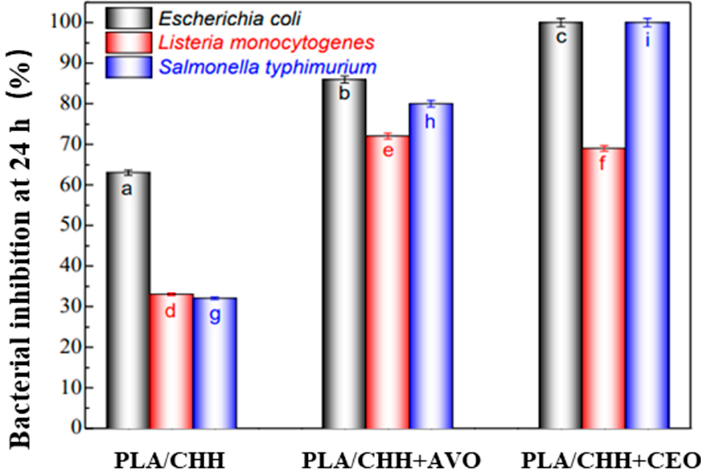
Figure 7. Variation of bacteria percentage inhibition determined by the CHH and oil-loaded CHH coatings. Ref. [91], published by MDPI, 2021. a–i values indicate significant differences at p < 0.05.